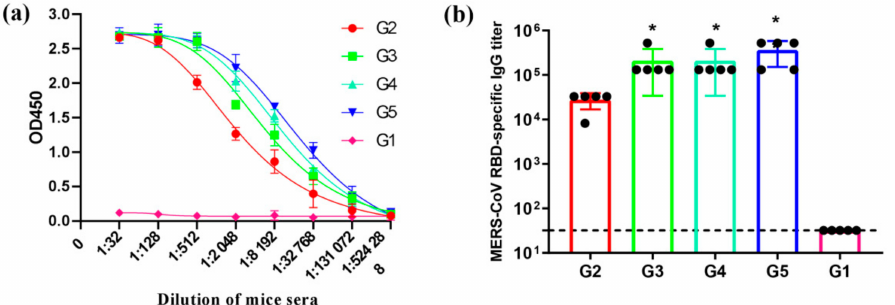
Figure 3. MERS-CoV receptor-binding domain (RBD)-specific IgG antibodies. Sera from 2 weeks after the last immunization were tested for MERS-CoV RBD-specific IgG antibodies by enzyme-linked immunosorbent assay (ELISA). The data are shown as the mean ± SD from five mice in each group and were analyzed by Student’s t -test (* p < 0.05, n = 5). ( a ) The total IgG antibodies specific to MERS-CoV RBD protein were assessed by ELISA. The level of the MERS-CoV RBD-specific IgG ( b ) antibodies was determined by ELISA and is shown as end-point dilution